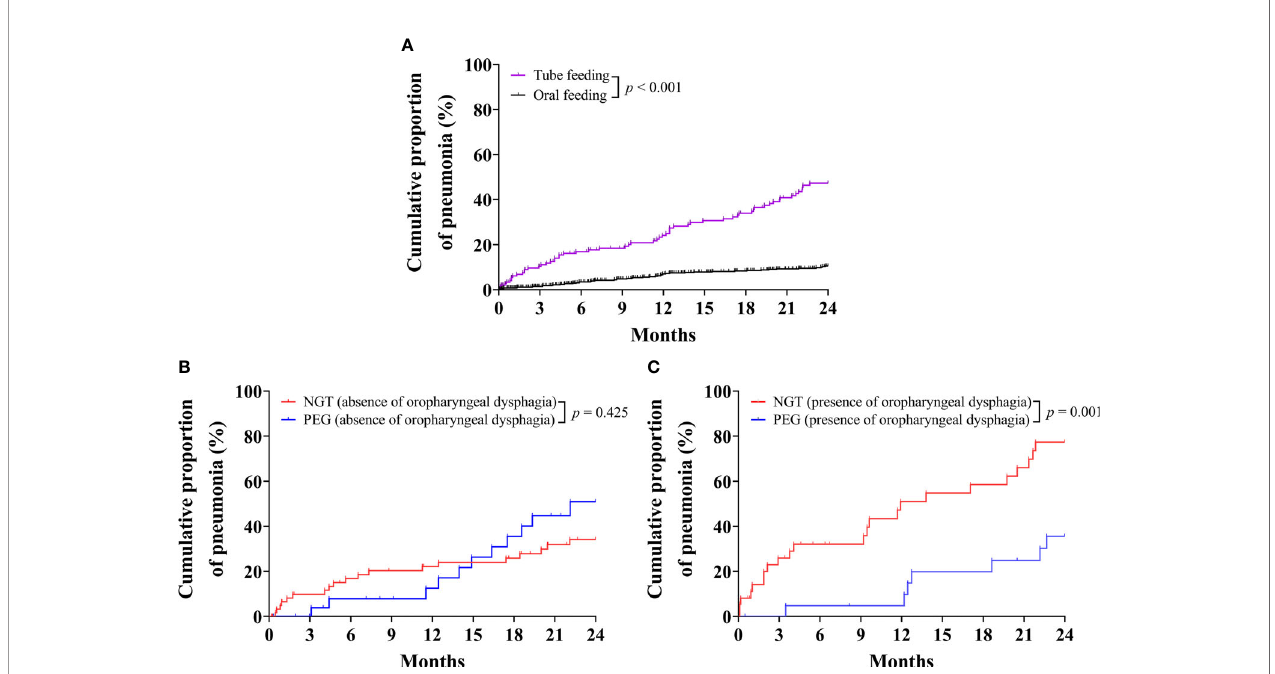
FIGURE 4 | Kaplan – Meier curves for the cumulative proportion of pneumonia requiring hospital admission in older patients. (A) Cumulative proportion of pneumonia in older patients for tube-feeding and oral-feeding group. (B) Cumulative proportion of pneumonia in older patients without oropharyngeal dysphagia for nasogastric tube (NGT) and percutaneous endoscopic gastrostomy (PEG) groups. (C) Cumulative proportion of pneumonia in older patients with oropharyngeal dysphagia for NGT and PEG